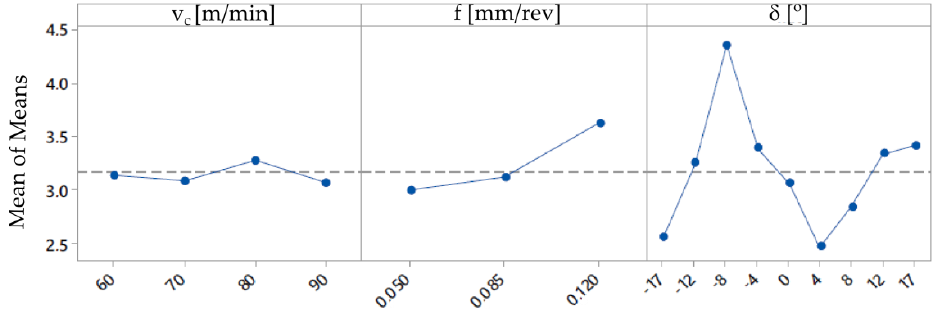
Figure 8. Graphs representing the relation between the surface roughness Rz and the cutting speed v c , feed rate f and tilted angle δ .